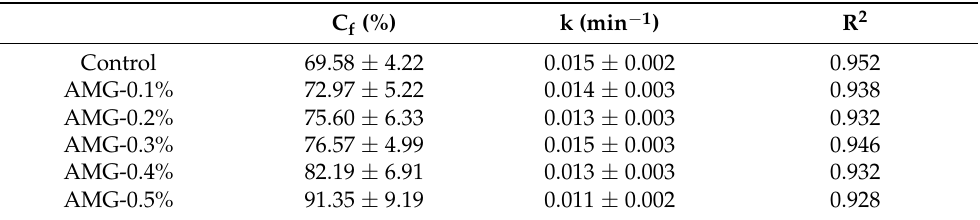
Figure 4. In vitro digestibility ( A ) and digestion kinetics ( B ) of meat proteins in frankfurters with or without AMG at different concentrations. Control: no added AMG; AMG-0.1%: 0.1% added AMG; AMG-0.2%: 0.2% added AMG; AMG-0.3%: 0.3% added AMG; AMG-0.4%: 0.4% added AMG; and AMG-0.5%: 0.5% added AMG. Table 7. Kinetic parameters of the in vitro digestion of frankfurters with or without AMG at different